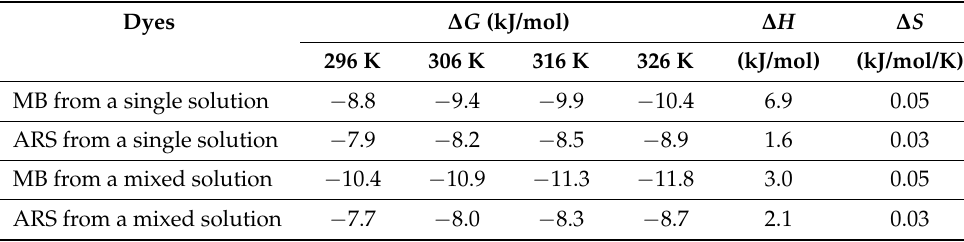
Table 2. Thermodynamic parameters of ARS and MB sorption on the HNC.